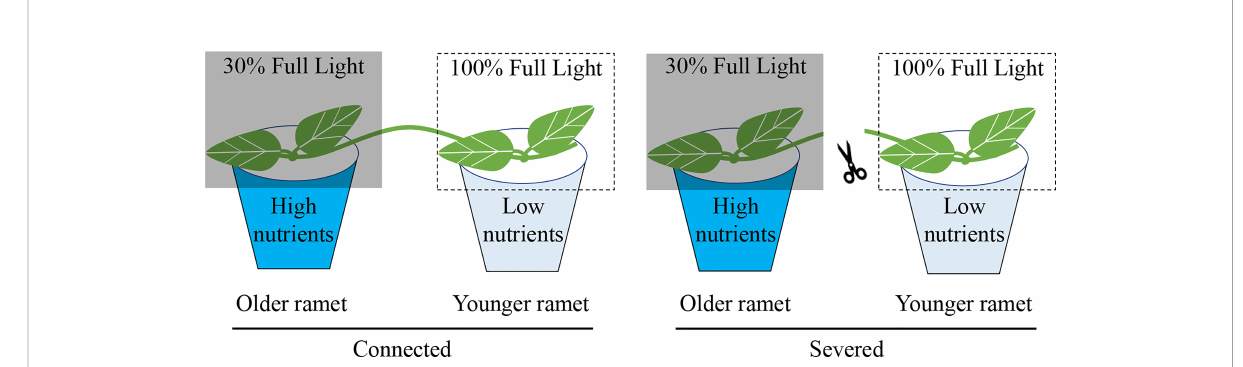
FIGURE 1 Schematic representation of the experiment design. Each clonal fragment consisted of a developmentally older and a developmentally younger ramet interconnected by a stolon internode. The older ramet was grown in a low-light (30% full light) and high-nutrient condition (with nutrient addition) and the younger ramet in a high-light (100% of full light) and low-nutrient condition (without nutrient addition). The stolon internode between the older and the younger ramet was either severed or kept intact